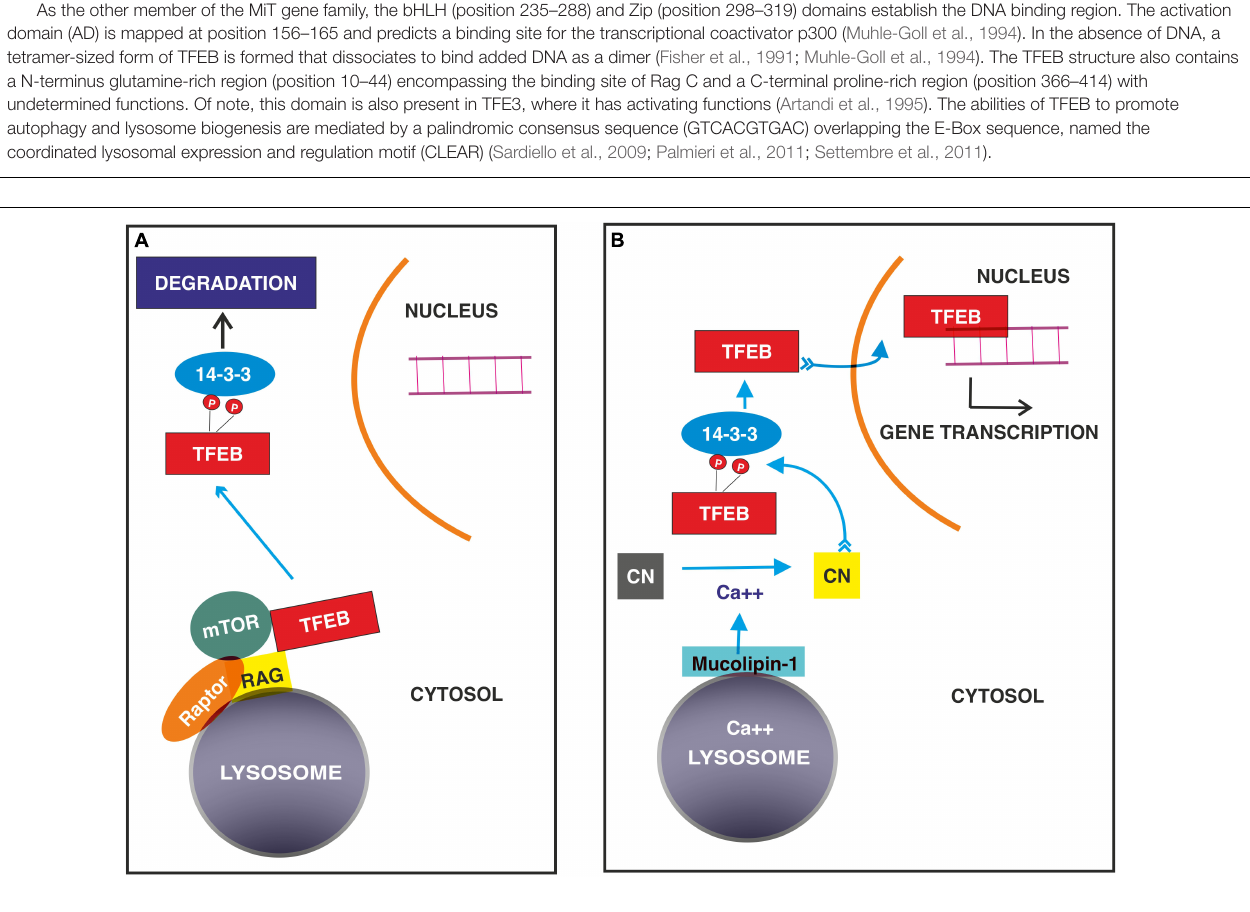
FIGURE 2 | Signaling mechanisms regulating TFEB nuclear translocation in normal (A) and stressed conditions (B) . (A) TFEB binds GTP- RagGTPase on the surface of lysosome followed by the recruitment of Raptor and mTOR. This complex allows the phosphorylation of TFEB, which interacts with 14-3-3 adaptor with subsequent degradation. (B) In stressed conditions, calcium ions released from lysosomes through mucolipin 1 channel activates the protein phosphatase calcineurin, (CN) which dephosphorylates TFEB, allowing its nuclear